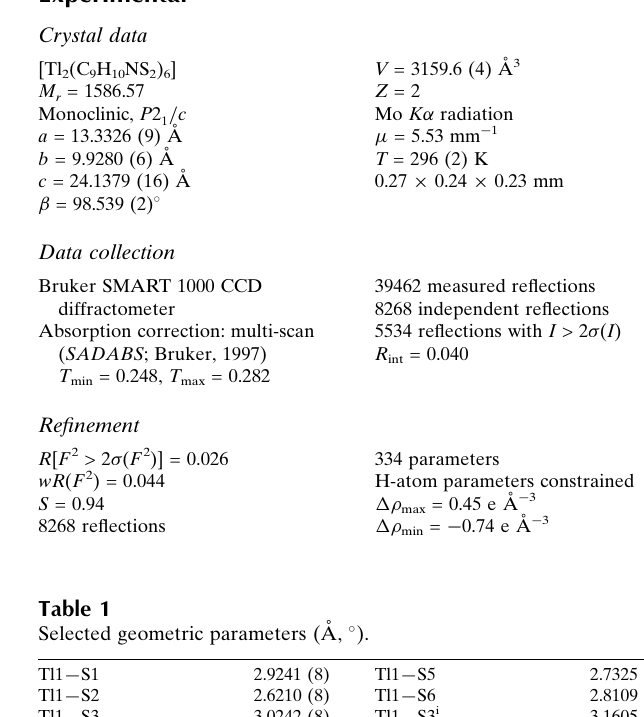
molecule dinuclear compound,